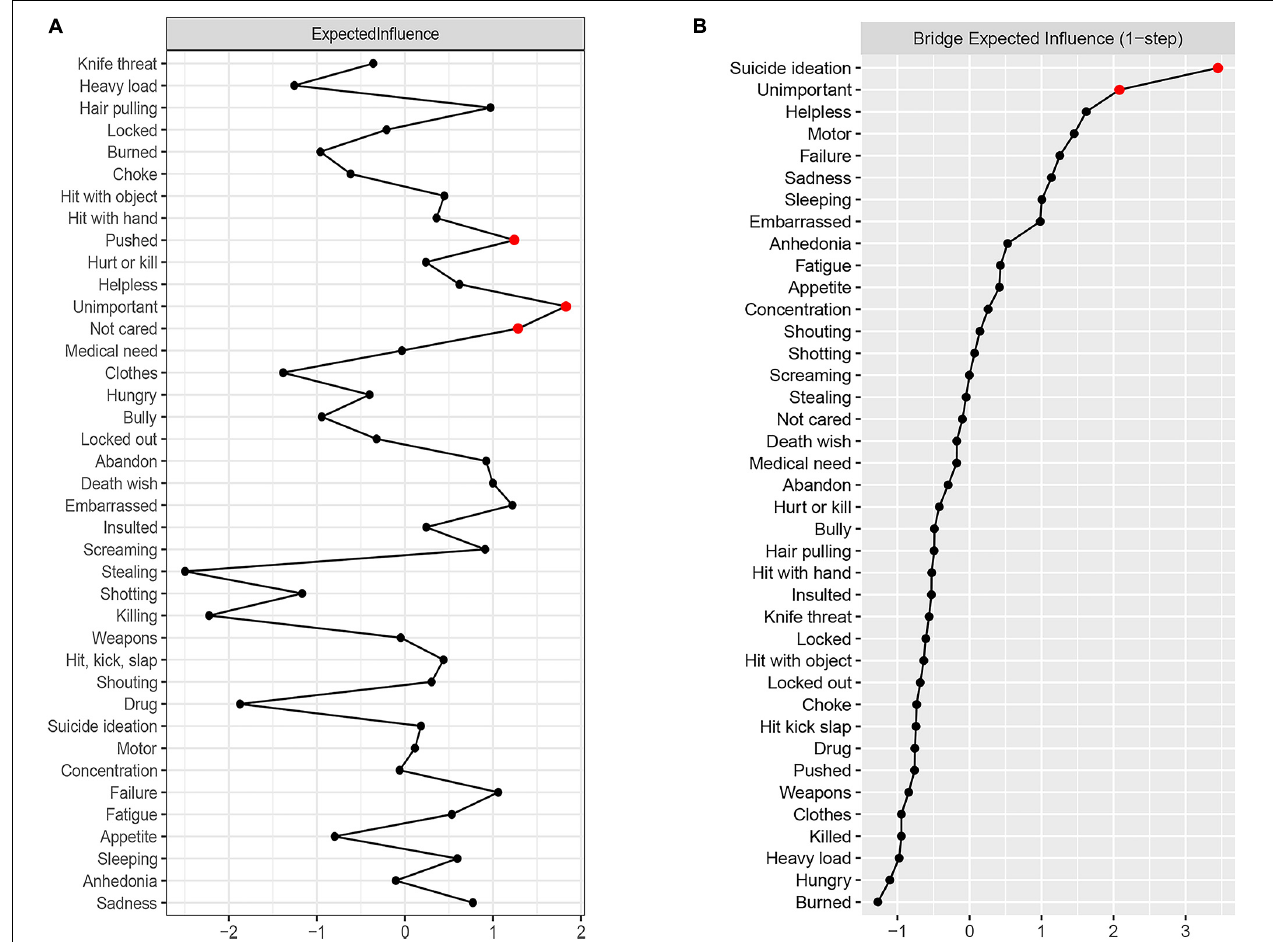
FIGURE 4 | Centrality plot of the expected influence (A) and bridge expected influence (B) of abuse events and depression symptoms in the network